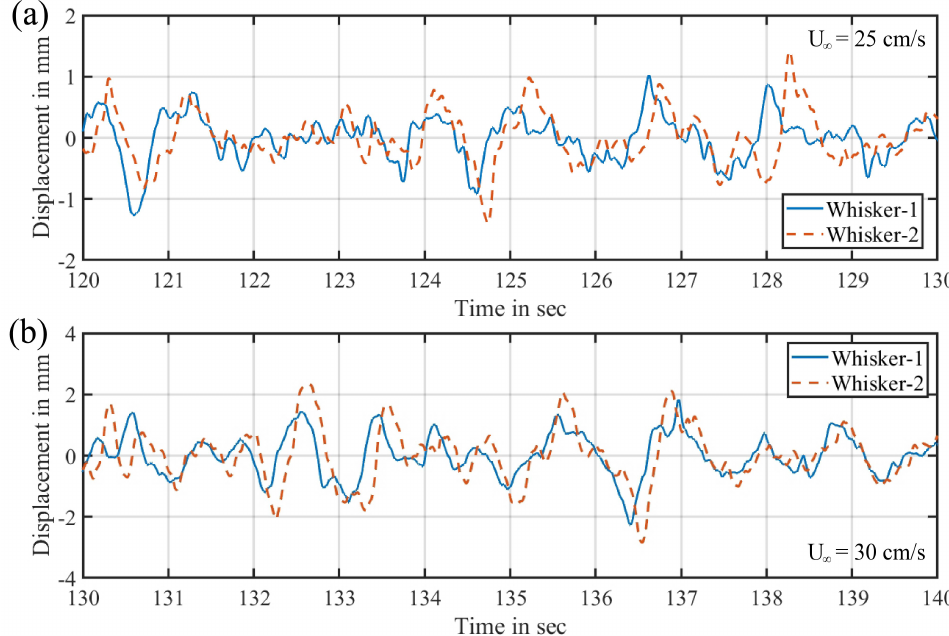
Figure 5. Fluctuating tip-motion of a pair of whiskers w1 and w2 in the wake of the cylinder ( a ): freestream velocity U ∞ = 25 cm/s, ( b ): freestream velocity U ∞ = 30 cm/s. The time-traces show a series of similar characteristic jerk motions, off-set from each other by the time taken for vortices to travel the distance between the whiskers (mean component